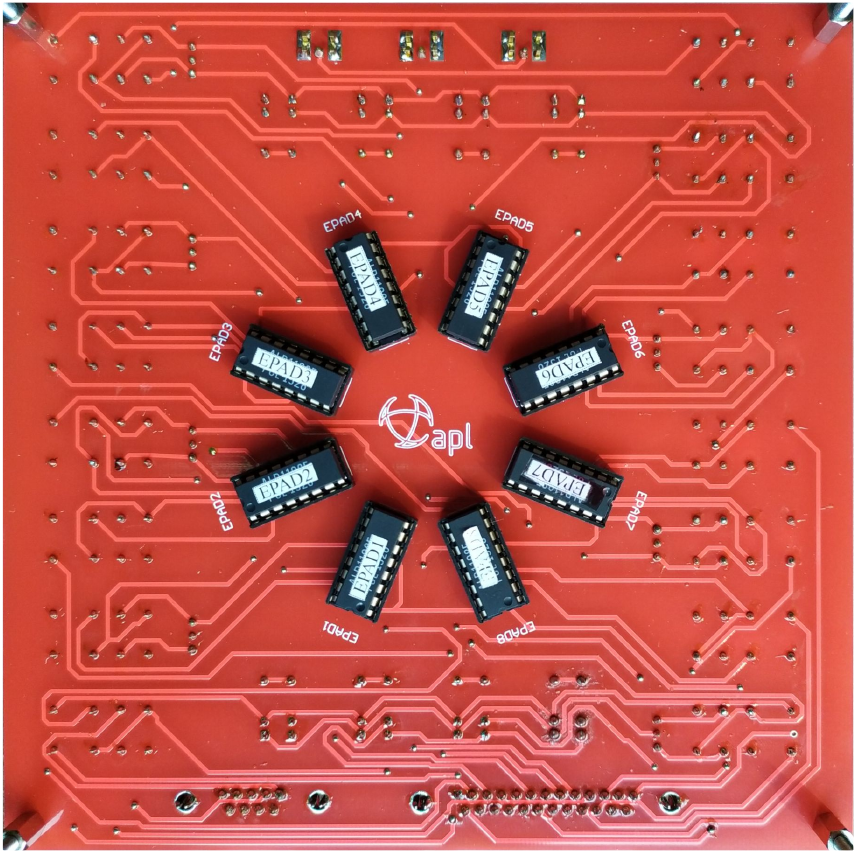
Figure A5. PCB bottom of mainboard with irradiated